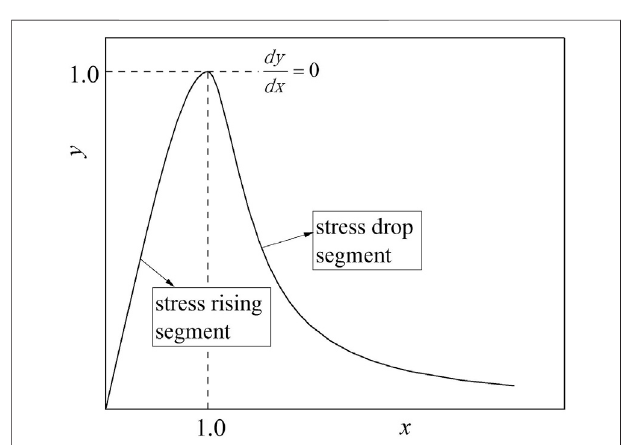
FIGURE 12 | Constitutive model of